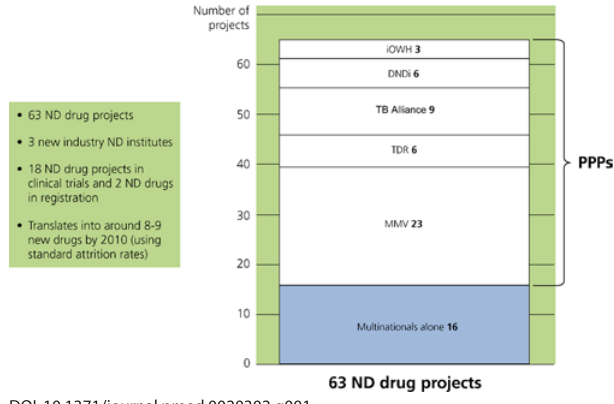
Figure 1. Active Neglected-Disease Drug Projects by Institution* (Dec 2004) DNDi, Drugs for Neglected Diseases Initiative; IOWH, Institute for OneWorld Health; MMV, Medicines for Malaria Venture; ND, neglected